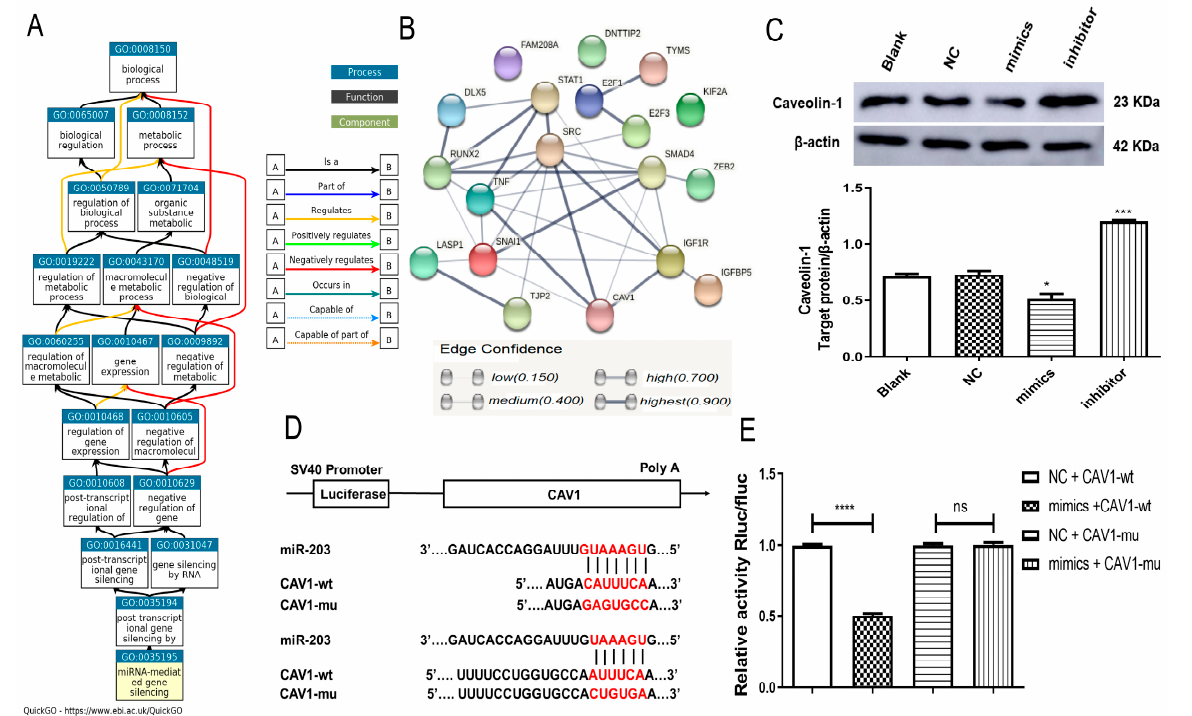
Figure 5. miR-203 binds to CAV1 and inhibits the expression of CAV1 . ( A ) Gene Ontology (GO-Biological Process) for miR-203 involved in gene silencing (GO: 0035195). ( B ) PPI network